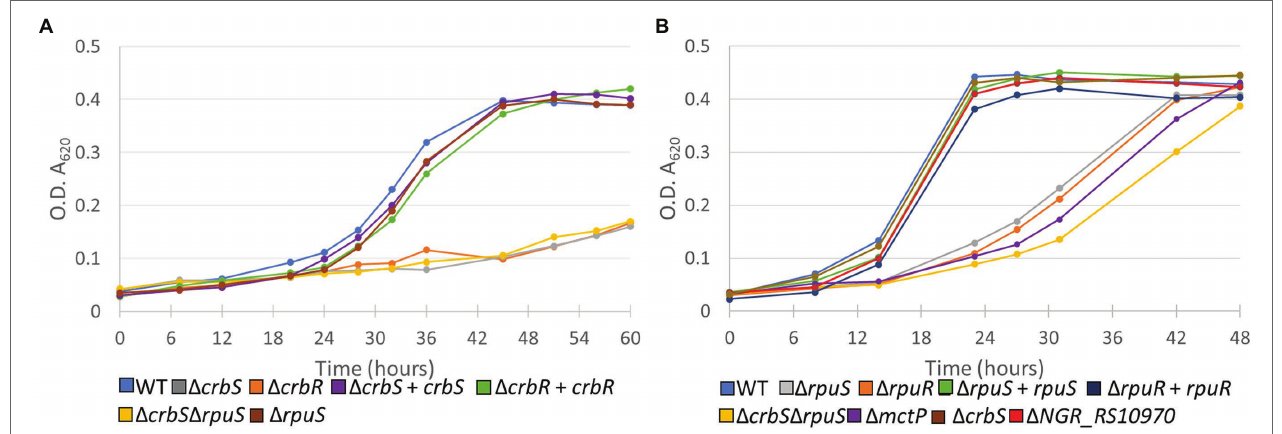
FIGURE 2 | Growth curves of deletion mutants of (A) CrbS/R and (B) RpuS/R TCSTS. Bacteria were grown in minimal medium complemented with (A) acetate or (B) pyruvate as sole carbon sources. Medium was not complemented with Kanamycin in any case. Expression from plasmid pSRKgm was induced with 100 mm IPTG. Results are means for six independent cultures. Empty pSRKgm controls for deleted mutants and non-induced controls for complemented strains were also tested but showed a negligible effect on growth phenotype and are not